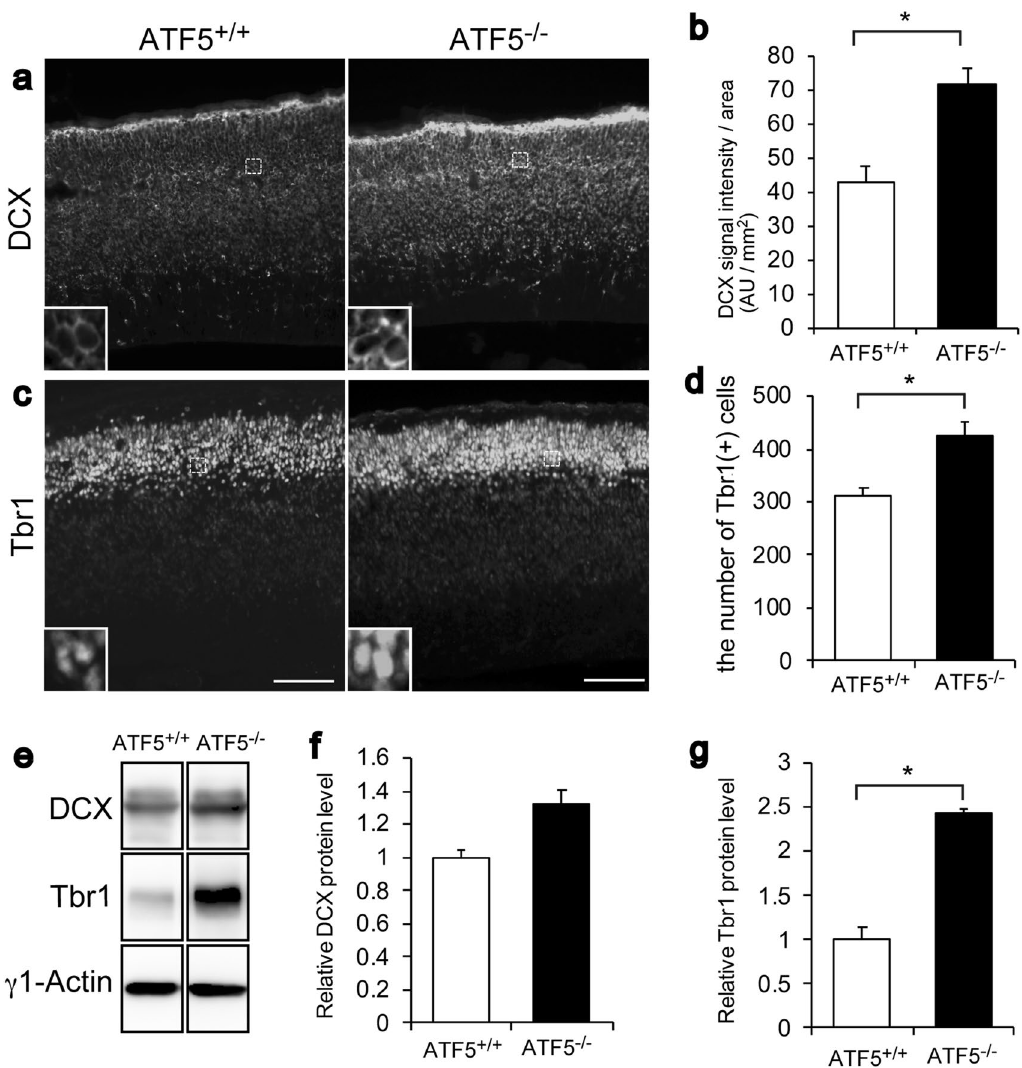
Figure 4. Increased numbers of immature neurons in the developing cortices of ATF5 −/− mice. ( a – d ) Immunostaining for the immature neuron markers DCX ( a ) and Tbr1 ( c ) in cortical sections on embryonic day 15 (E15). ( b ) Quantification of DCX intensity in images of DCX-immunostained tissues. ( d ) Quantification of the number of Tbr1-positive cells. Each inset shows an enlarged view of the dotted line box. ( e ) Western blotting analysis of DCX and Tbr1 protein levels in cortical lysates from ATF5 +/+ and ATF5 –/– mice on E15. γ1-Actin was used as a loading control. ( f , g ) Quantification of the relative band intensities of DCX and Tbr1 normalised to γ1-actin. Data are presented as mean ± S.E.M. ( n = 3 mice per group in ( a – d ), n = 5 mice per group in ( e – g ), * p < 0.05; Student’s t-test). Scale bars represent 100